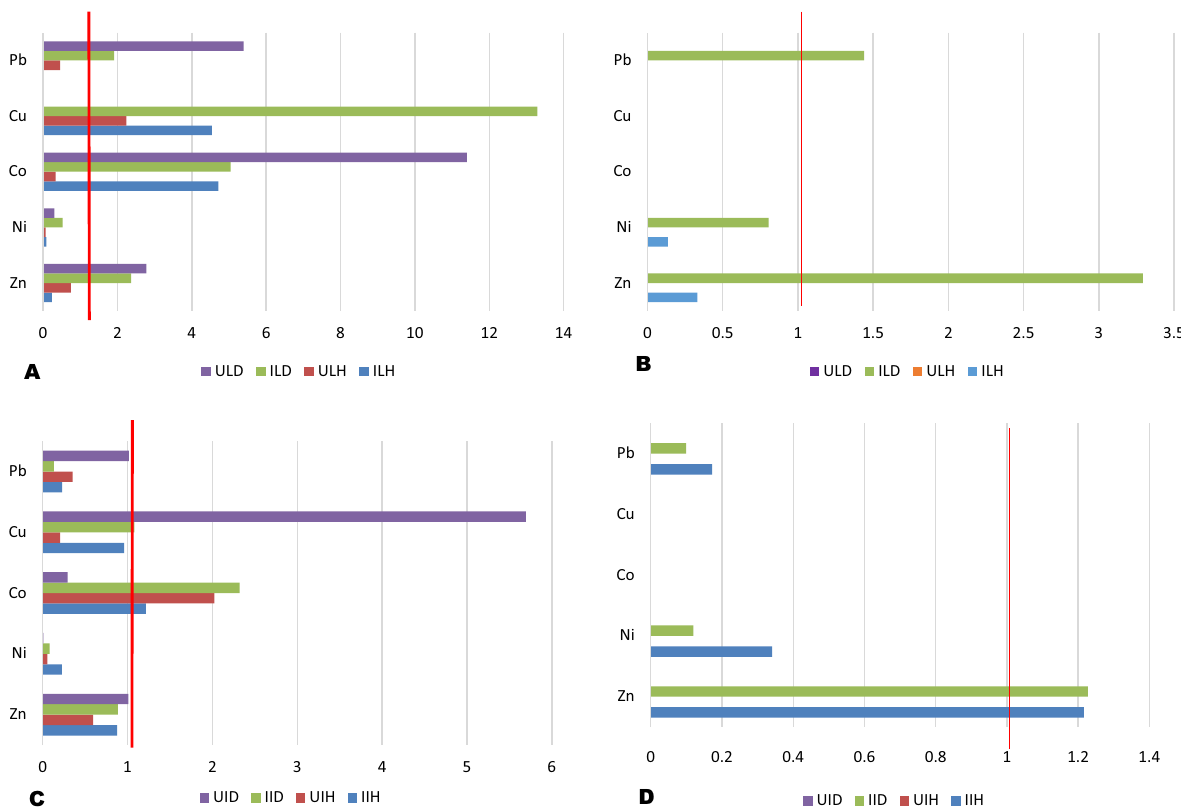
liver/ sediment biota-sediment = intestine/ parasite = uninfected liver at habitat, = infected intestine at =